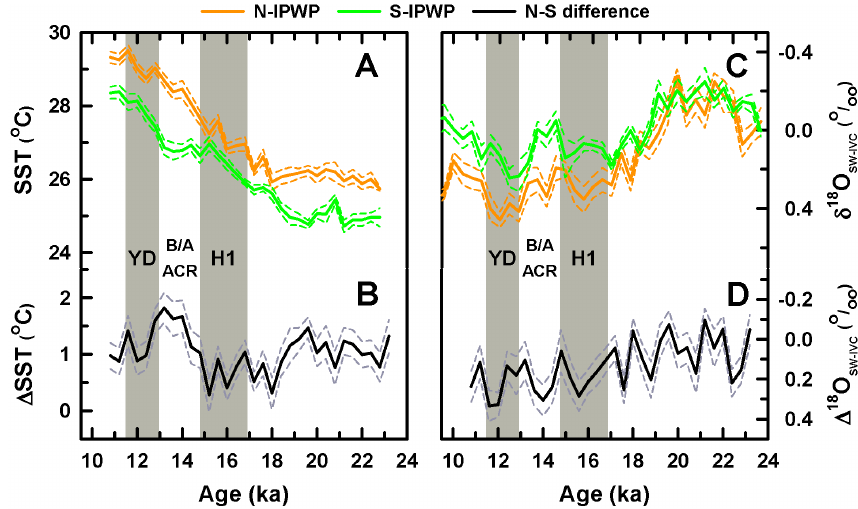
Figure 5. Four-hundred-year nonoverlapping binned (a) SST and (c) δ 18 O SW IVC of N- (orange solid line) and S-IPWP (green solid line). − Lower panels show the differences in (b) SST and (d) δ 18 O SW IVC between N- and S-IPWP. The compilations of N- and S-IPWP surface − water thermal and hydrological records (Table 2) were calculated with the nonoverlapping binned methods (Oppo et al., 2009; Linsley et al., 2010). All dashed lines represent 1 σ uncertainty ranges. Gray bars show the H1 and YD